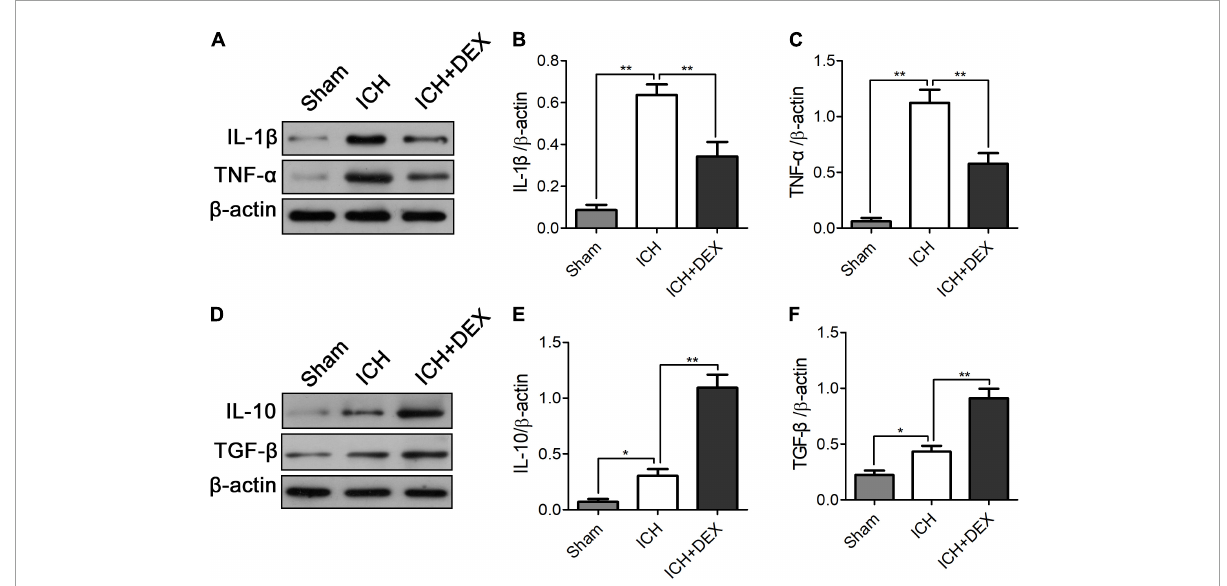
FIGURE5 On the 3rd-day post-ICH, compared with the sham operation group, the protein levels of M1 expression products, including TNF- α and IL-1 β , and M2 expression products, including IL-10 and TGF- β , were significantly increased in the ICH group. DEX significantly decreased the production of TNF- α and IL-1 β (A–C) . Simultaneously, enhanced IL-10 and TGF- β were observed in the DEX group (D–F) . * p < 0.05, ** p < 0.01.